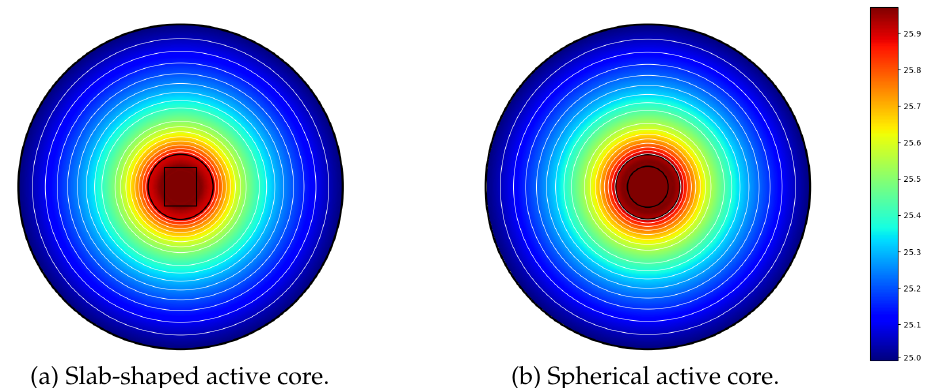
Figure 2. Finite elements modeling of heat transfers through the multi-physics system: NTC + Fluid, with: ( a ) a slab-shaped active-core; ( b ) a spherical active core. In both cases, the same materials were considered for the sheath (epoxy, external radius a s = 1 mm), the active core (semiconductor material), and for the surrounding fluid (radius a f = 5 mm) to be